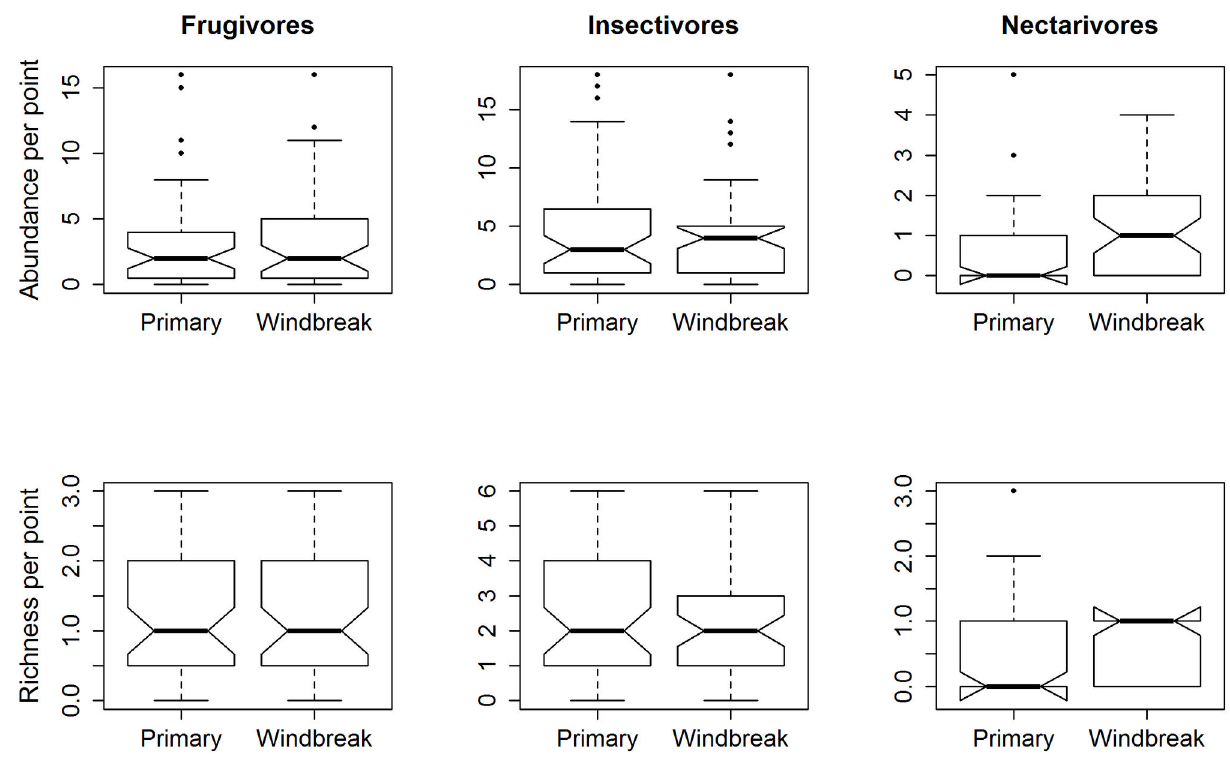
Figure 3. Notched box-plots showing the resilience of guild structure (abundance and richness) between primary forests and windbreaks. If the notches in the box plots do not overlap, you can conclude with 95% confidence that the true medians do differ. Plots show that nectarivorous birds were more resilient in windbreaks (Supplementary Table S4). doi: